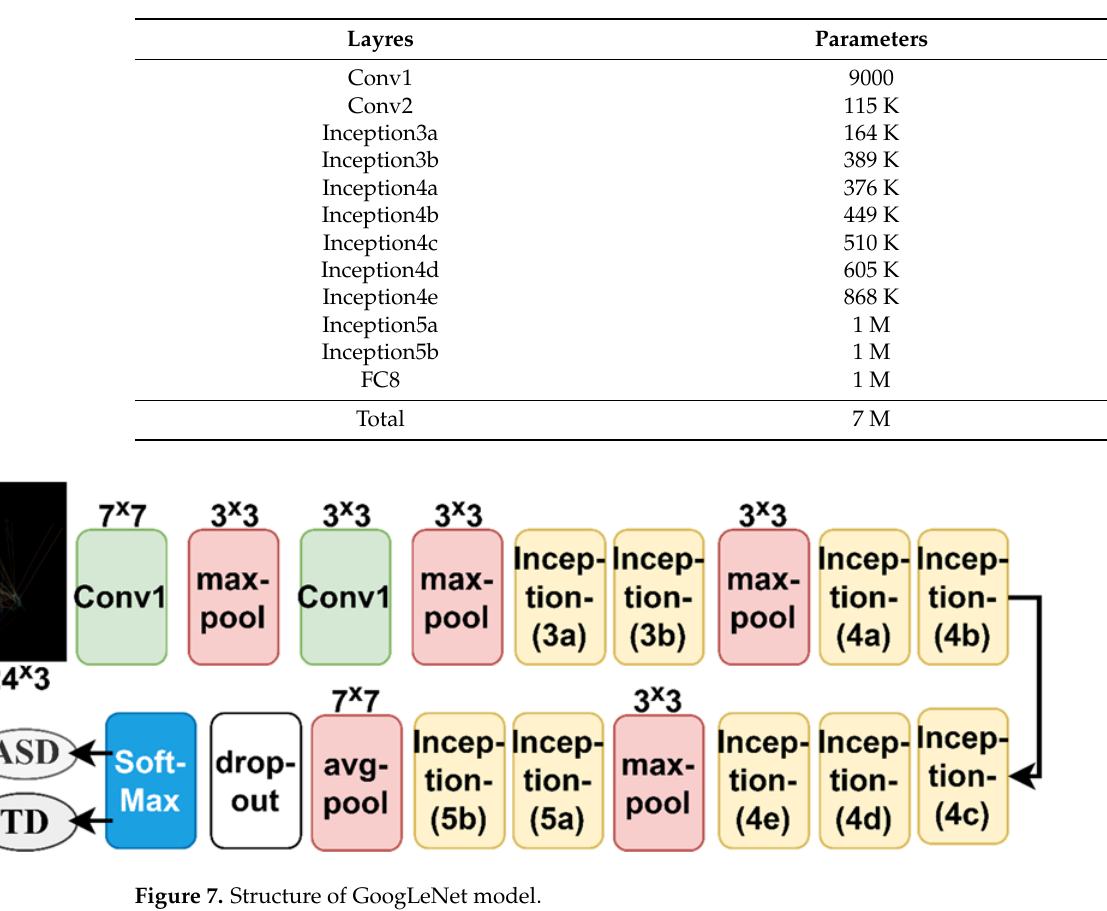
Table 2. The number of parameters per layer in the ResNet ‐ 18 model.